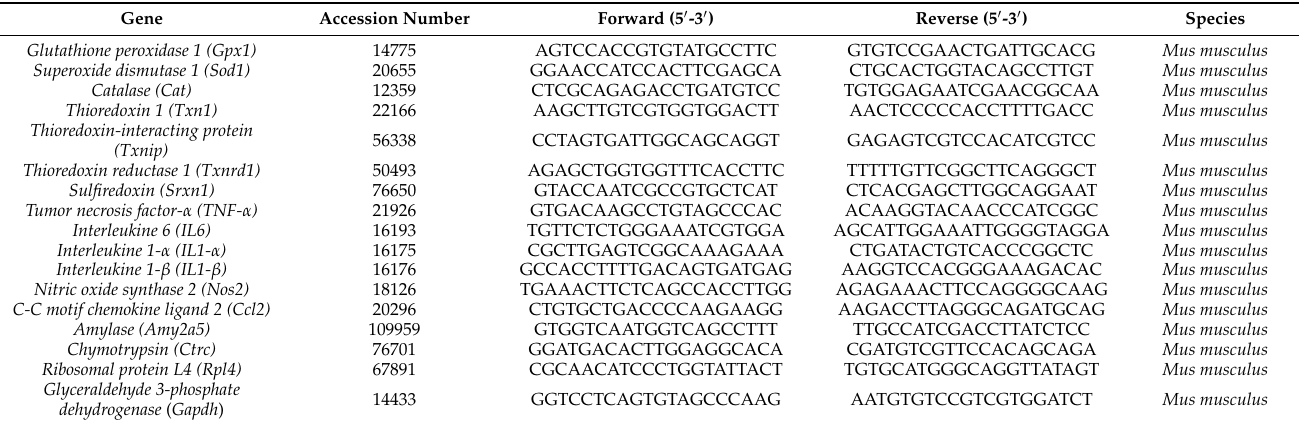
Table 2. PCR primers used in the present